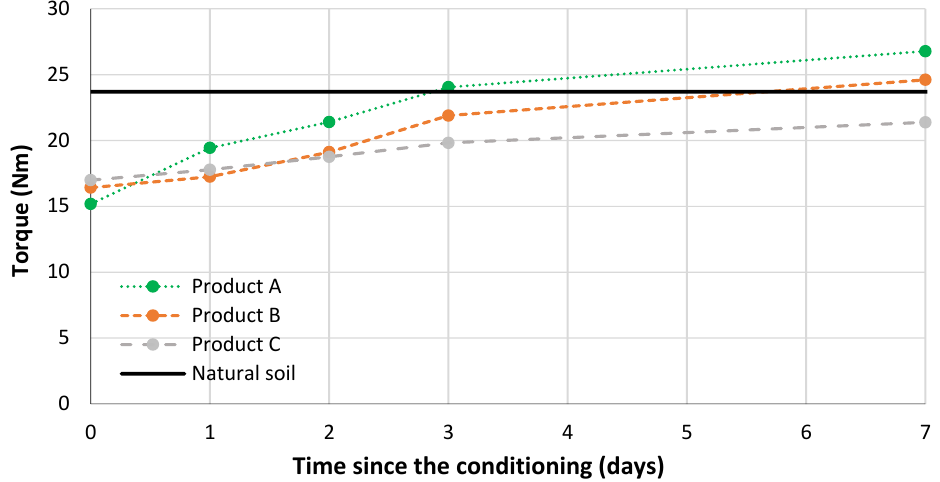
Figure 8. Results of rotational mixer test for products A, B, and C.